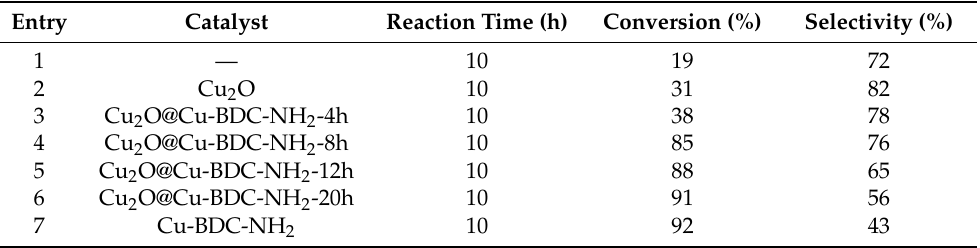
Table 2. Catalytic performance of Cu 2 O and Cu 2 O@Cu-BDC-NH 2 in selective oxidation of styrene to benzaldehyde a .